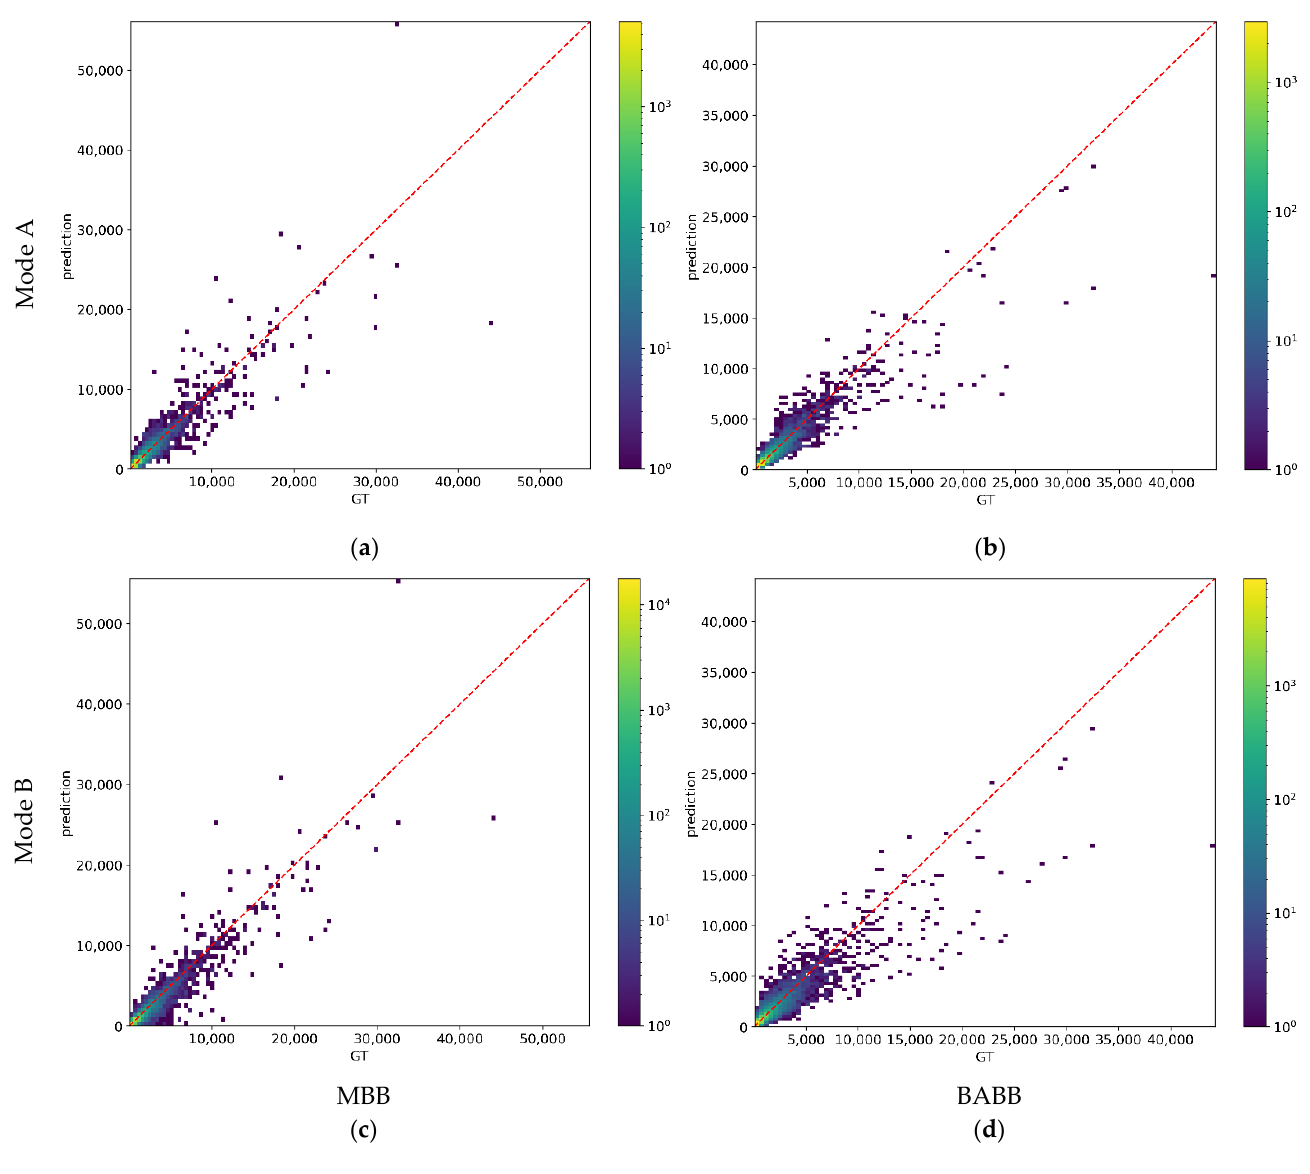
Figure 8. Joint distribution of prediction and GT of BA. ( a ) The results of MBB in mode A. ( b ) The results of BABB in mode A. ( c ) The results of MBB in mode B. ( d ) The results of BABB in mode B. y = x is plotted in red in each subfigure.